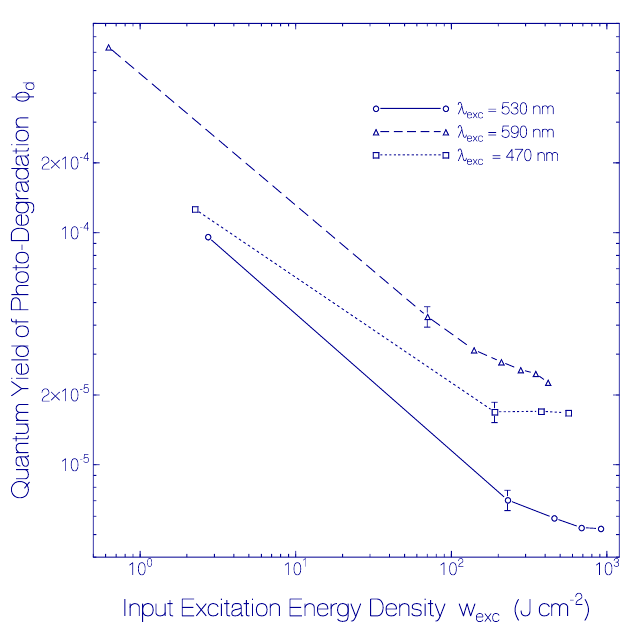
Figure 12. Quantum yields of photo-degradation of CaRh in pH 7.3 HEPES/MOPS buffer versus accumulated input excitation energy density w exc for sample exposure with LED 590 nm (triangles), LED 530 nm (circles), and LED 470 nm (squares). Data of Figures 10 and 11a were applied in the φ d calculation.